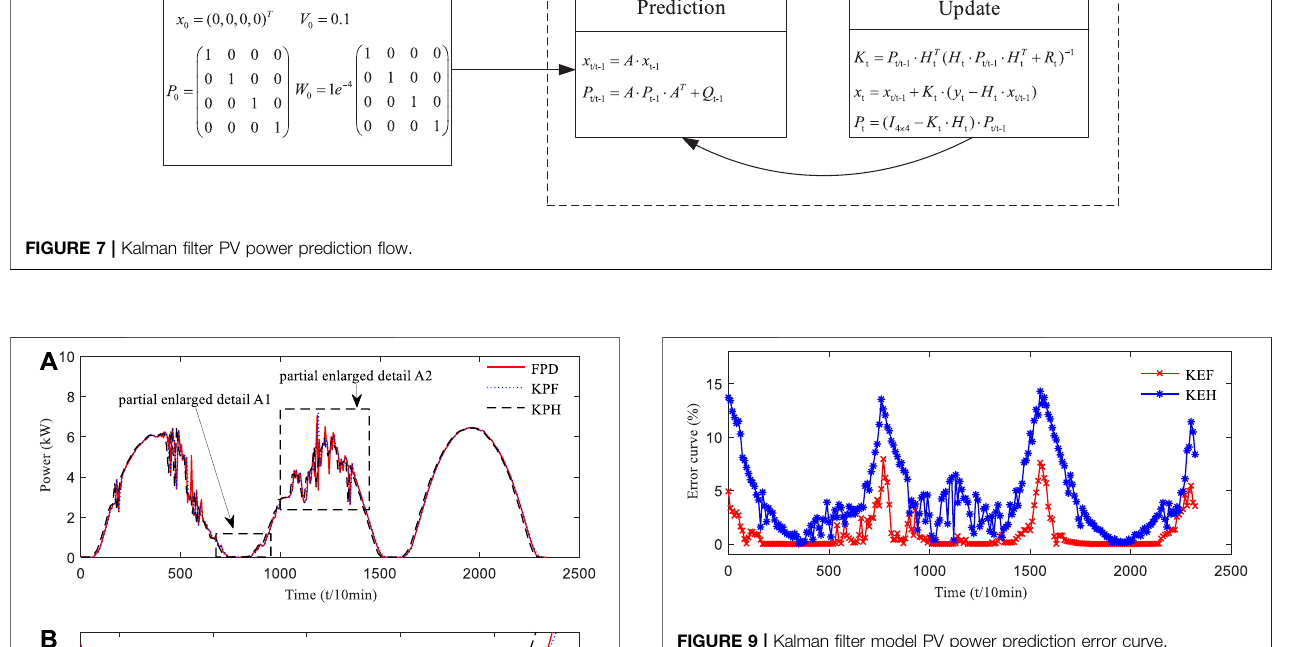
FIGURE 9 | Kalman fi lter model PV power prediction error curve.